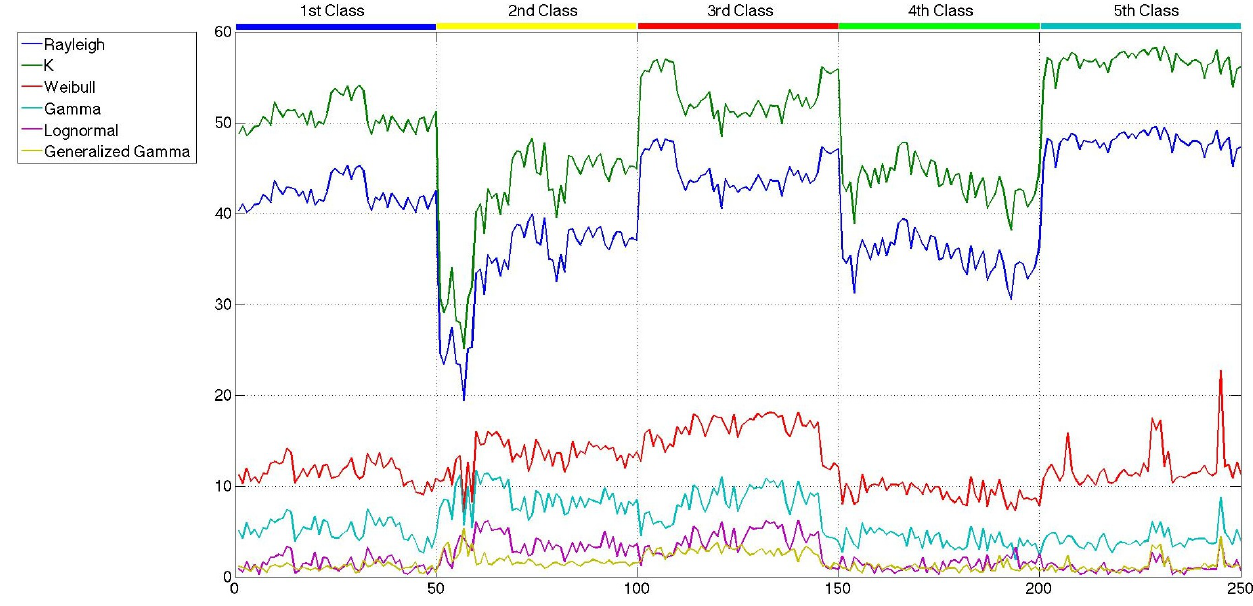
Cramér–von Mises distances measured for a reduced set of representative mean-shift-filtered